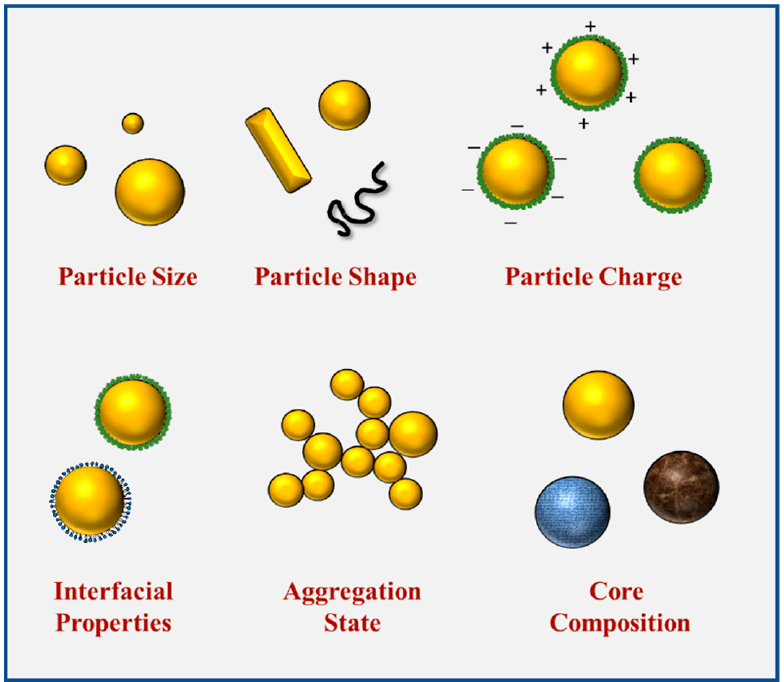
Figure 2. The characteristics of food-grade nanoparticles, including size, shape, composition, aggre- gation, and interfacial properties.